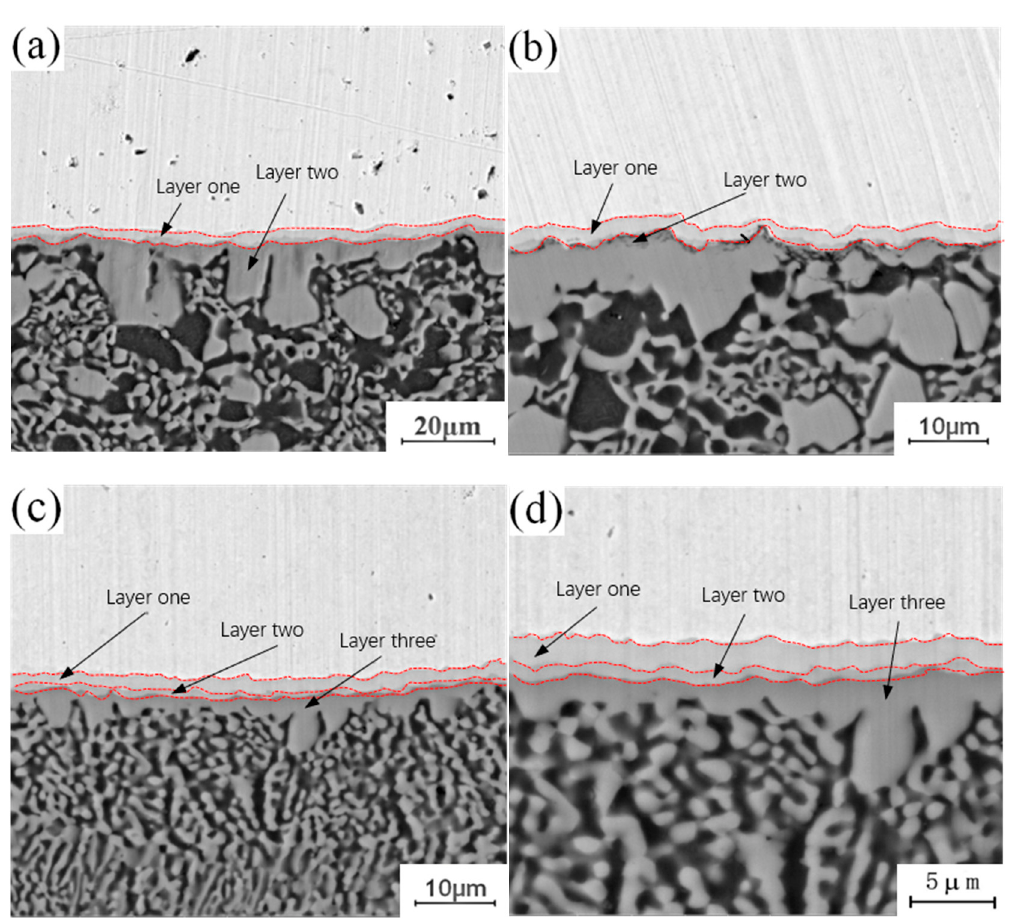
Figure 3. EDS analysis of copper–aluminum lap joint: ( a ) Cu-Al joining interface between copper and aluminum; ( b ) Intermetallic compound (IMC) layer; ( c ) Microstructure of crystal region; ( d ) c point copper and aluminum content; ( e ) d point copper and aluminum content.